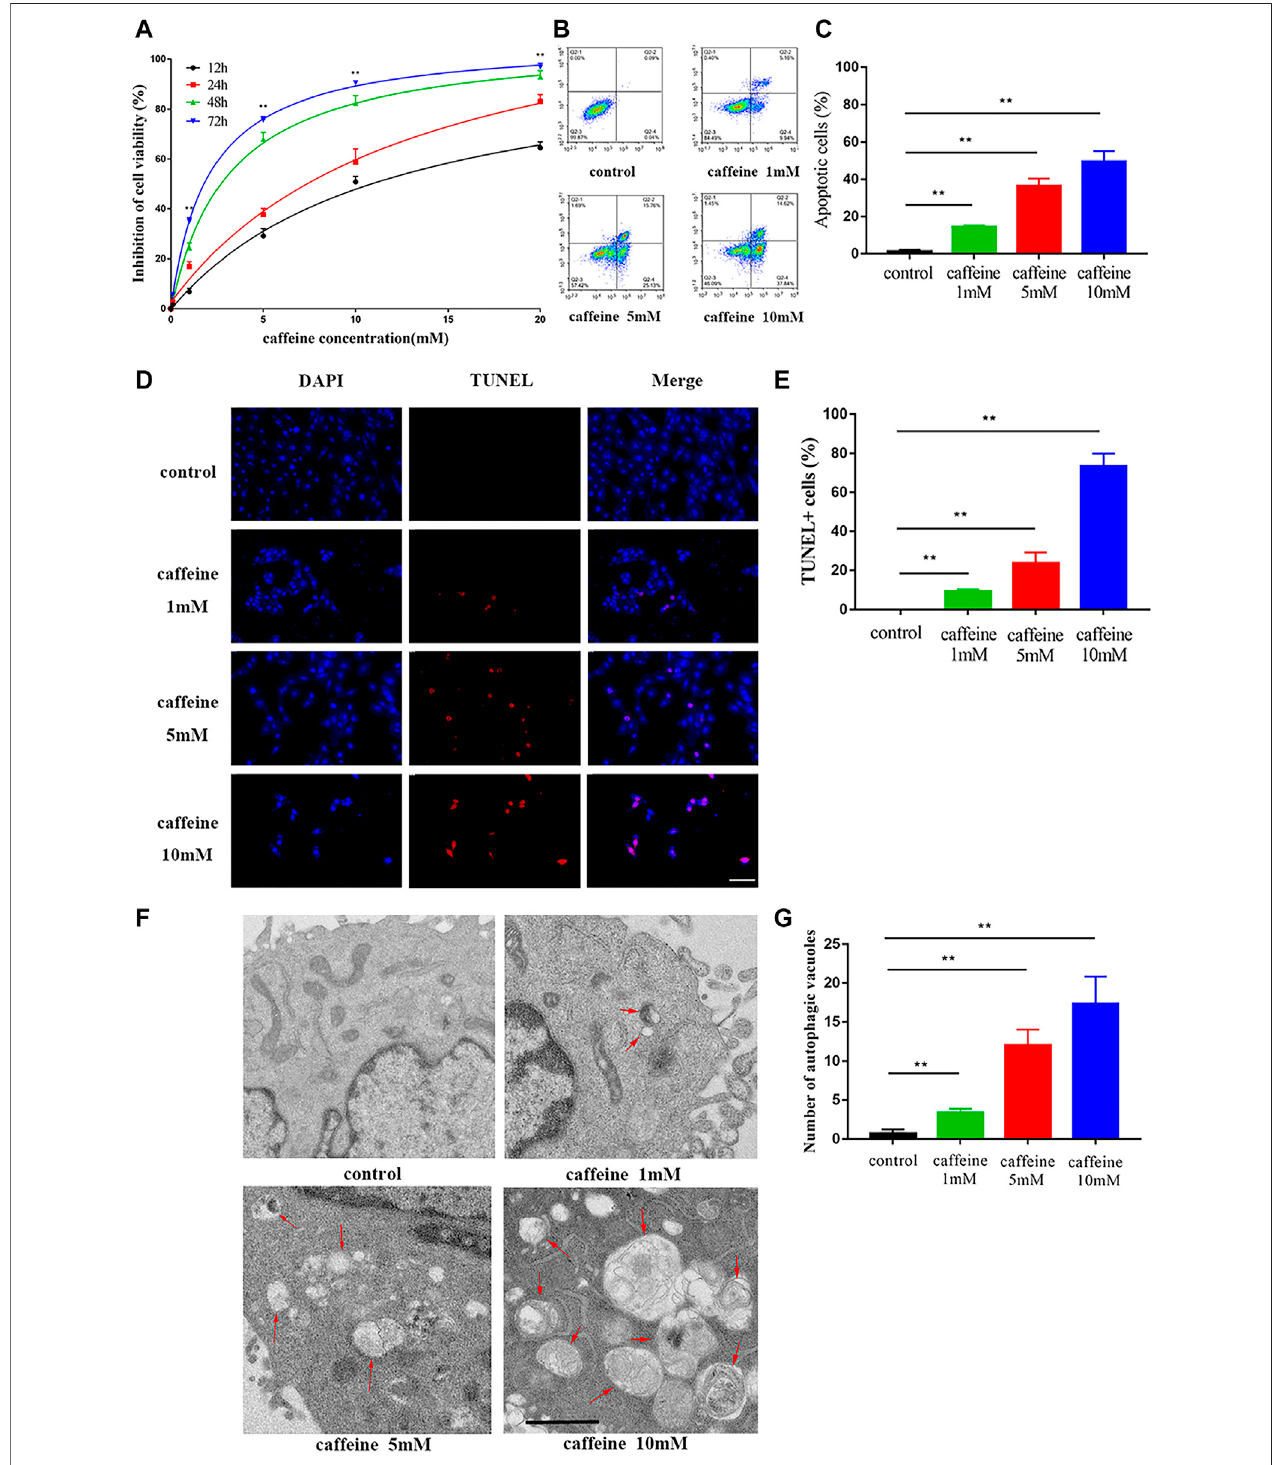
FIGURE3| CaffeineinducedautophagyandapoptosisinHEI-OC1. (A) CCK-8kitwasusedtomeasurecellviabilityinHEI-OC1cellsafterdifferentincubationtimes withvaryingconcentrationsofcaffeine(from0to20 mM). (B – C) Thepercentofapoptosisafter24 hofcaffeinetreatmentwithdifferentconcentrationswasmeasuredby fl ow cytometry. Data are shown as means ± SD, **p < 0.01 . (D – E) TUNEL (red) and DAPI (blue) double staining showing the apoptotic HEI-OC-1 cells after different treatments. Scale bar: 100 μ m. Data are shown as means ± SD, **p < 0.01 . (F – G) Electron microscope analysis for evaluating autophagy in HEI-OC1 cells. Scale bar: 1 μ m. Data are shown as means ± SD, **p < 0.01 .